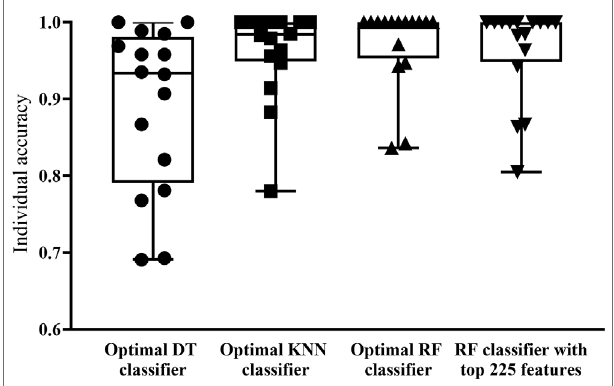
FIGURE 3 | Box plot to show performance of key classi fi ers on 16 cell types. RF and KNN classi fi ers have superior classi fi cation performance,